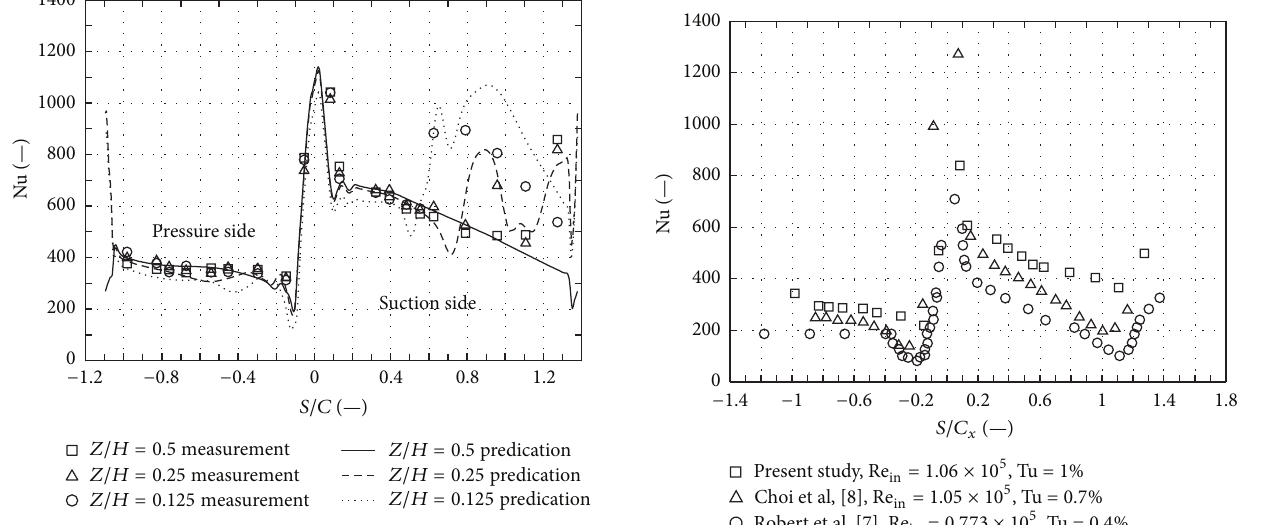
Figure 14: Nusselt number distribution at different locations through blade height, Re = 159000.